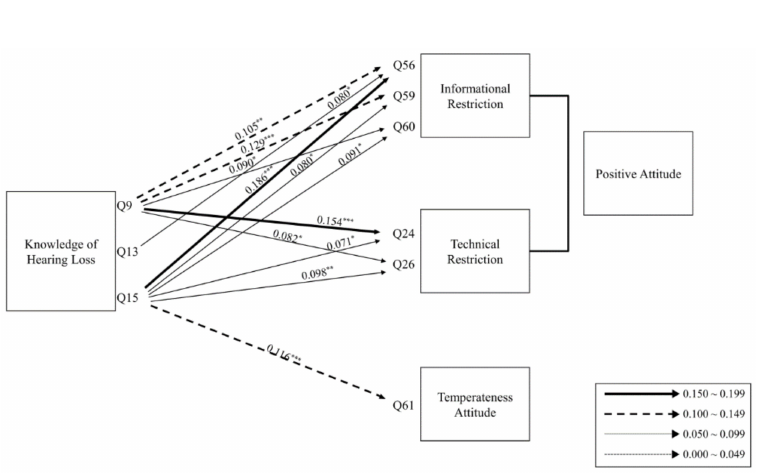
Figure 3. Path results for the second hypothesis based on the multiple regression model. * p < 0.05, ** p < 0.01, *** p <